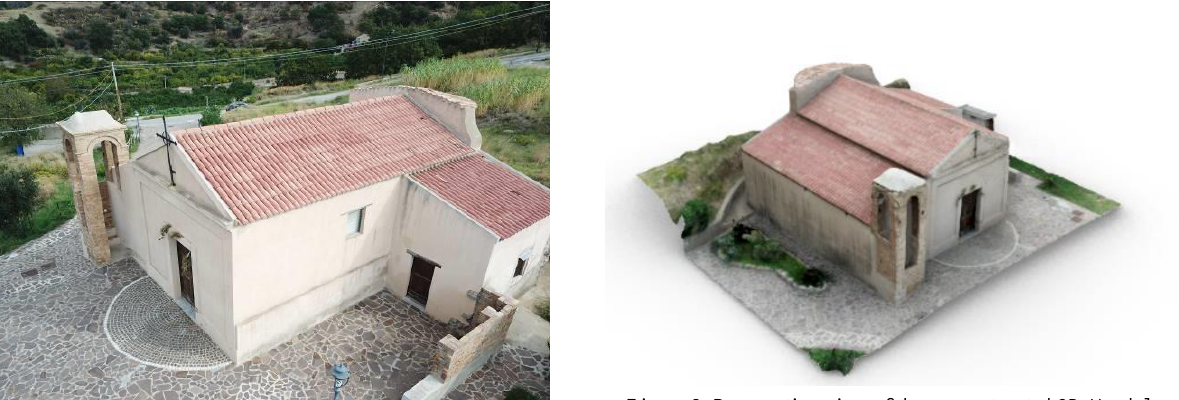
Figure 2. Perspective view of the reconstructed 3D Model – outside